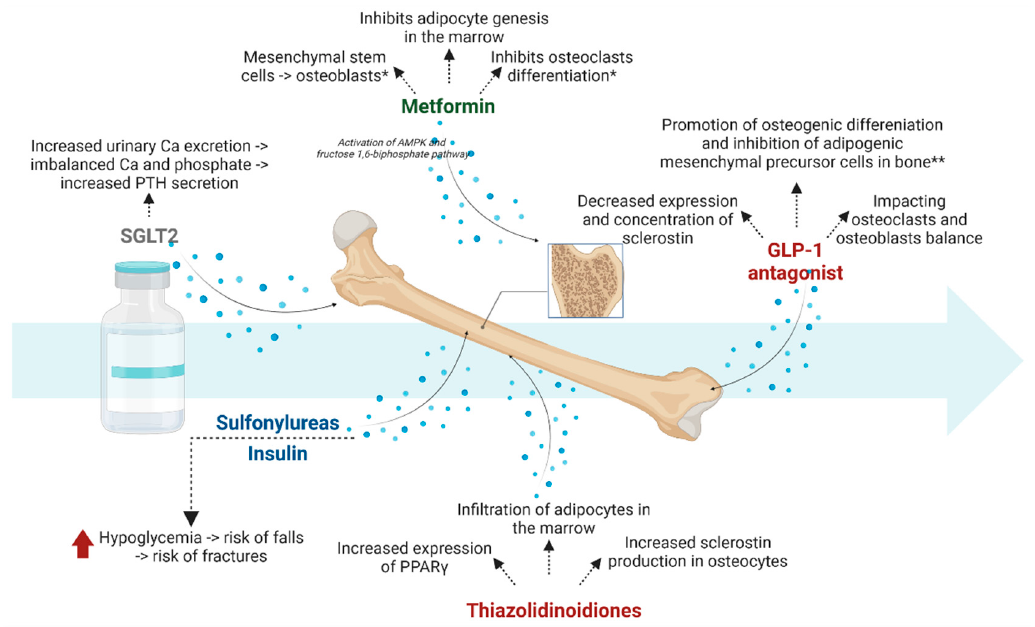
Figure 1. The mechanism of action of drugs used in diabetes on bone mineral metabolism. *—data come from observational studies; **—data come from in vivo studies; Ca-calcium; PPAR γ -peroxisome proliferator-activated receptor